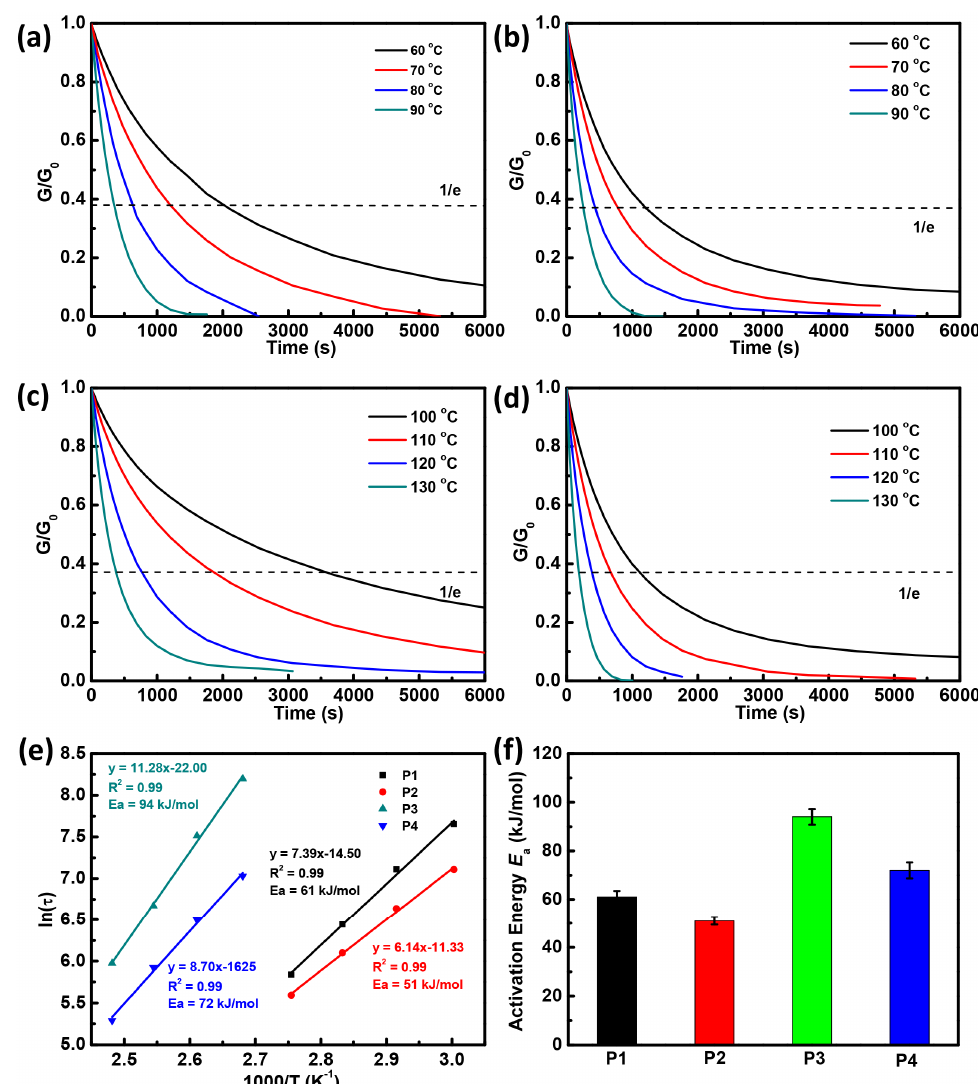
Figure 5. Normalized stress-relaxation curves for ( a ) films P1, ( b ) P2, ( c ) P3 and ( d ) P4 at different temperatures; ( e ) the Arrhenius analysis of P1, P2, P3 and P4; ( f ) the histogram of the activation energy of the films.